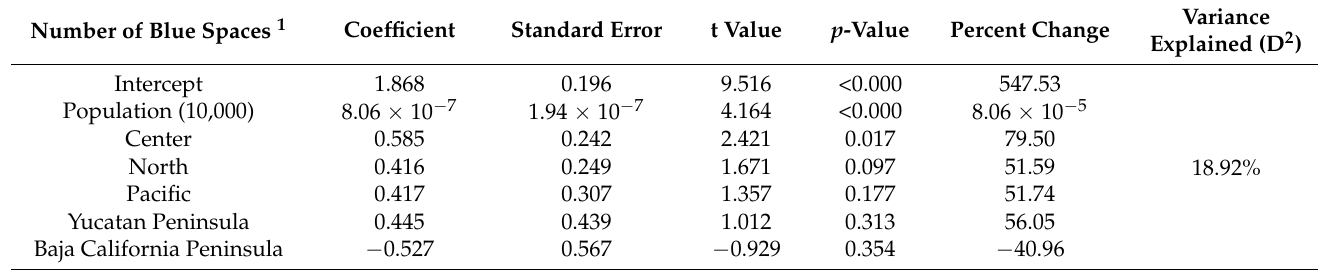
Table 2. Results from the model for the number of blue spaces, the city population, and the hydrolog- ical region where they are located.